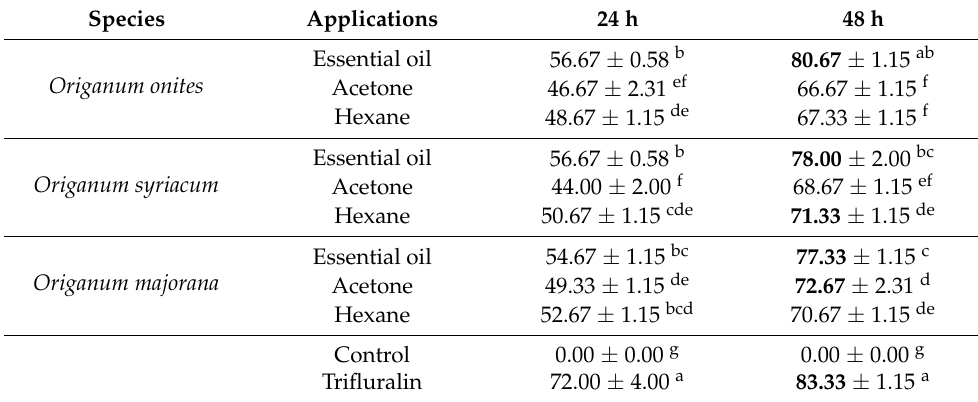
Table 6. The mortality rate (%) of Thlaspi arvense in